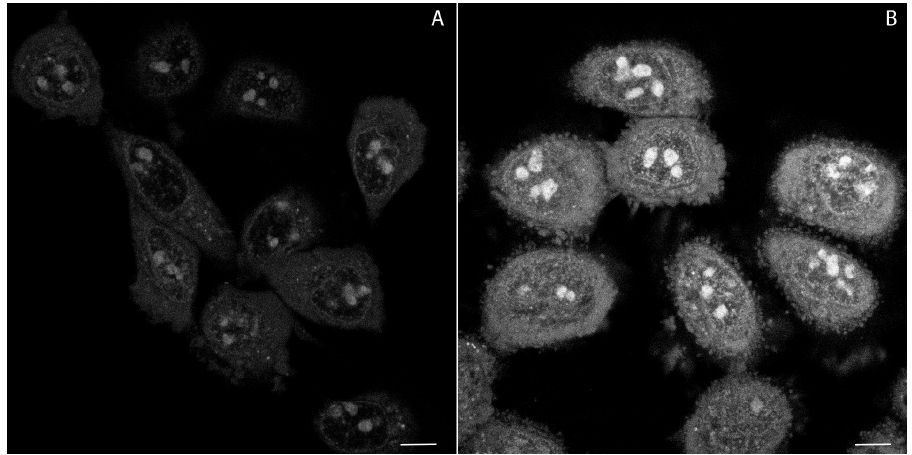
Figure 7. Production of reactive oxygen species (ROS) monitored with accumulation of ethidium (product of dihydroethidium (DHE) oxidation) after laser irradiation in the absence ( A ) and the presence ( B ) of compound 2 , in HeLa cells. Emission wavelengths are represented using a false colour. Scale bar—10 µm.